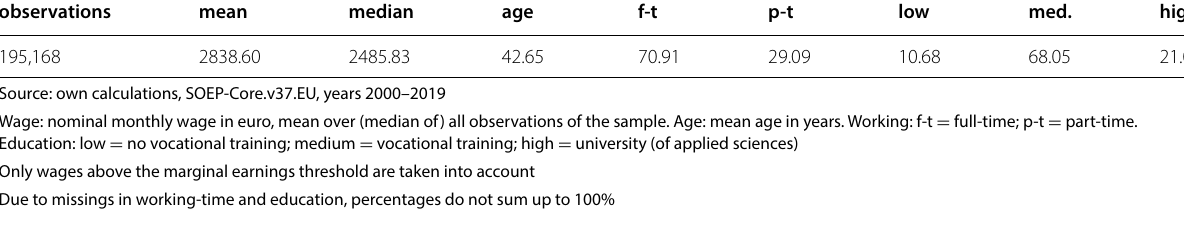
Table 3 Summary statistics SOEP: comparable sample 1